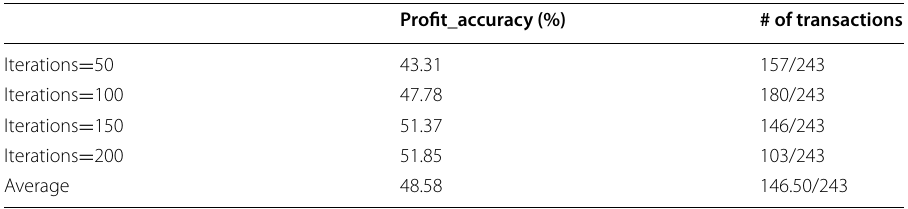
Table 9 TI_LSTM model: three‑days‑ahead result summary